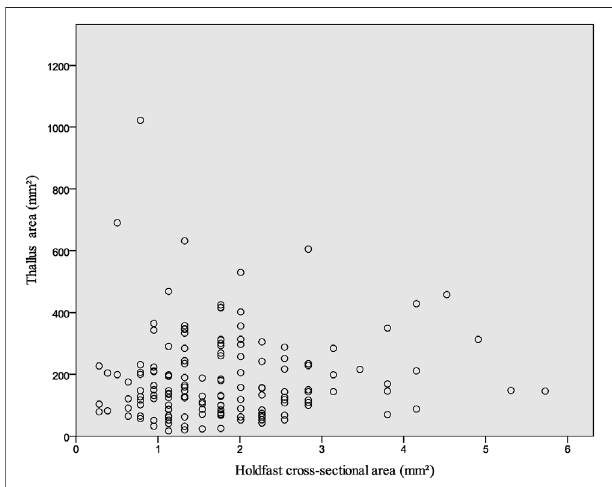
FIGURE 4 | Thallus area vs. holdfast cross-sectional area for macroalga Flabellophyton from the Lantian biota. N (cid:1) 154.